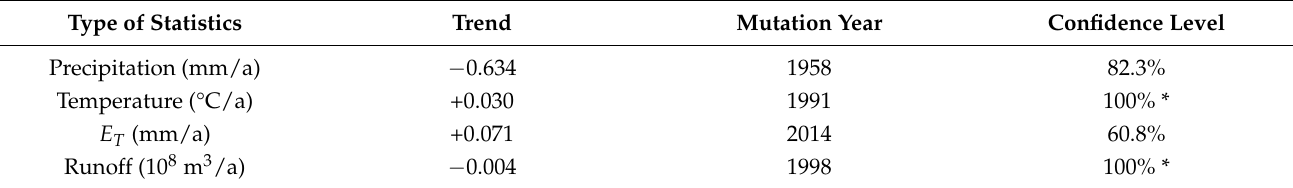
Figure 8. Variation process of the statistic S in the Guanyintang station. ( a ) Precipitation; ( b ) tempera- ture; ( c ) runoff; ( d ) evapotranspiration. Table 3. Results of the Mann–Kendall test in the Guanyintang station between 1956 and